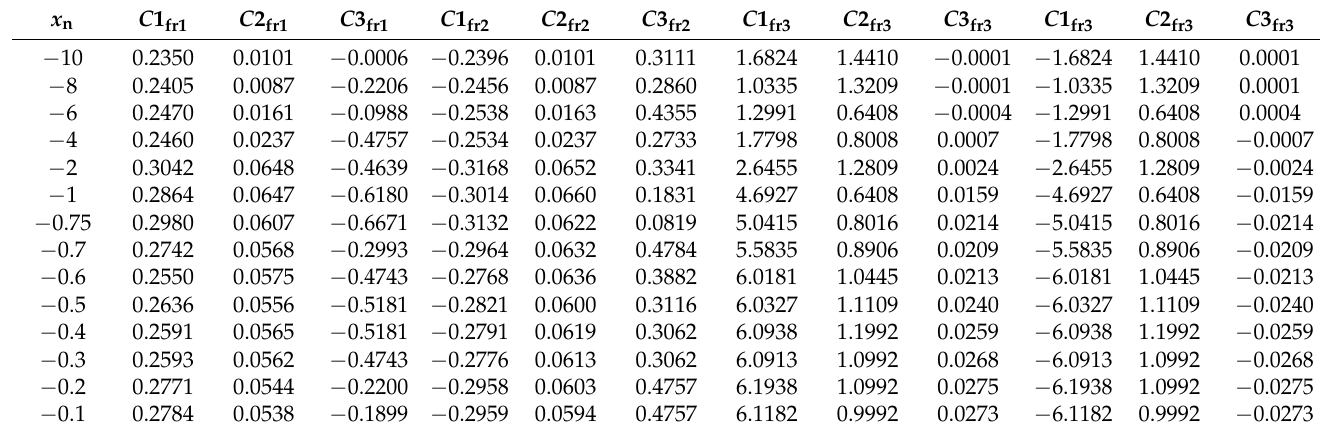
Table A5. The fitting parameters in resonance-type functions, f R_ i , ( x n < 0).